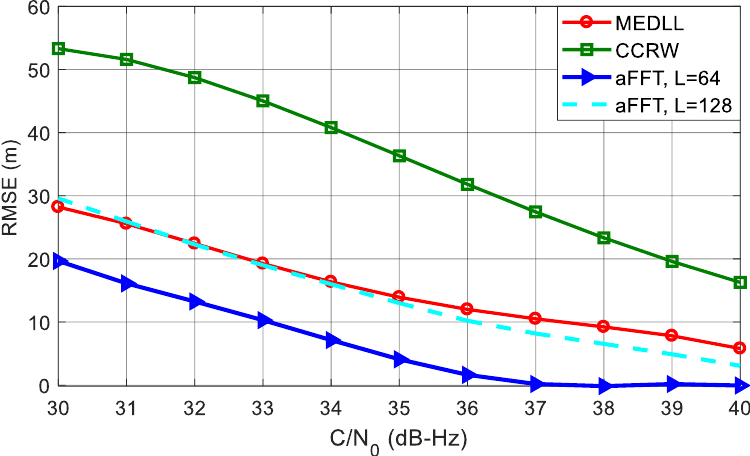
Figure 17. RMSE curves of different methods for BOC (15,2.5) signal with single reflected path.